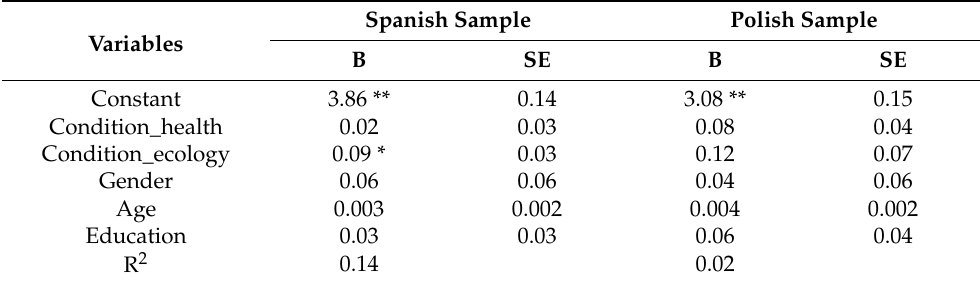
Table 2. Linear regression analysis predicting the evaluation of the proposed product in Spanish and Polish consumer samples; B = unstandardized beta, SE = standard error. Spanish Sample Polish Sample Variables B SE B SE Constant 3.86 ** 0.14 3.08 ** 0.15 Condition_health 0.02 0.03 0.08 0.04 Condition_ecology 0.09 * 0.03 0.12 0.07 Gender 0.06 0.06 0.04 0.06 Age 0.003 0.002 0.004 0.002 Education